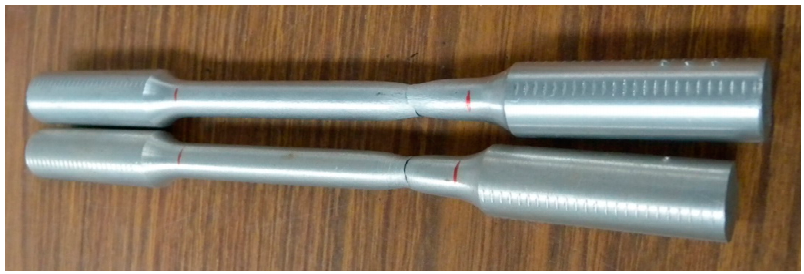
Figure 6. Tested A92030 tensile samples.